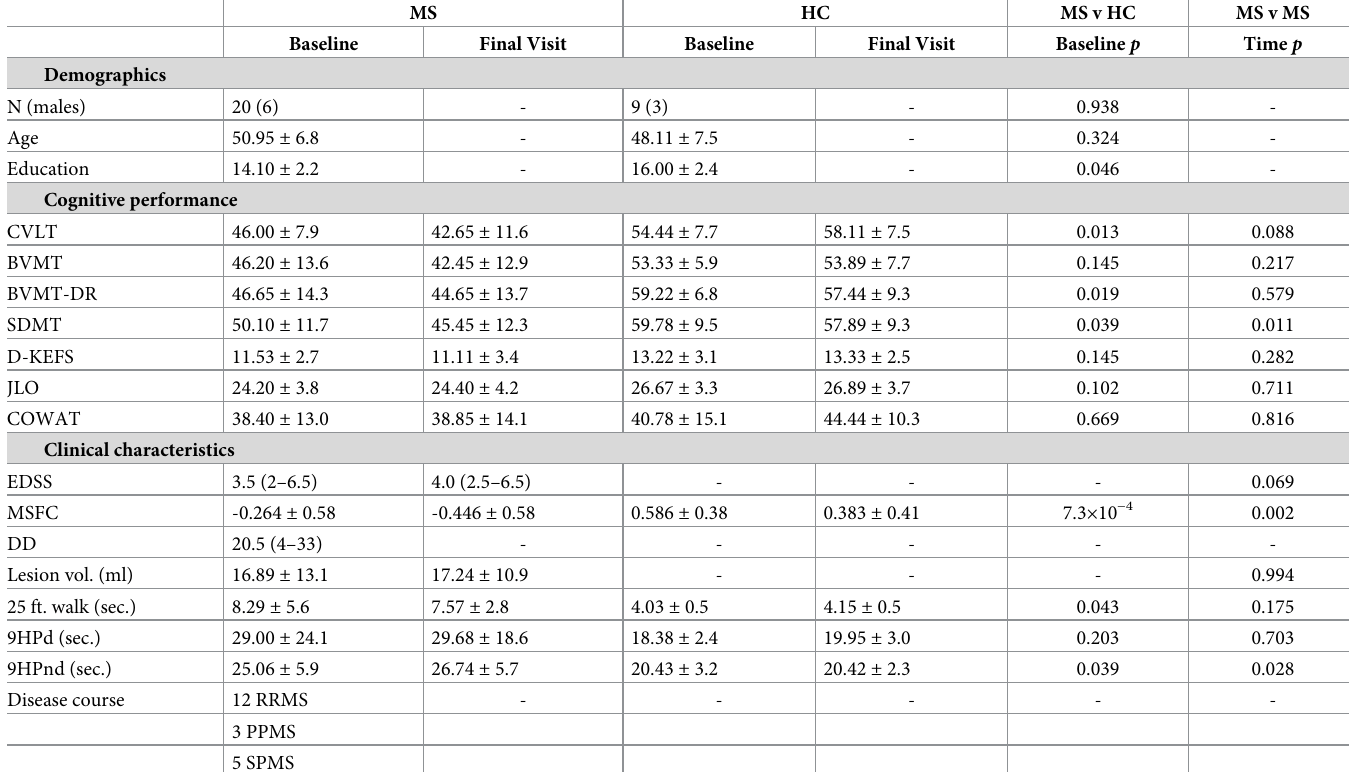
Table 2. Participant demographics, cognitive performance, and clinical